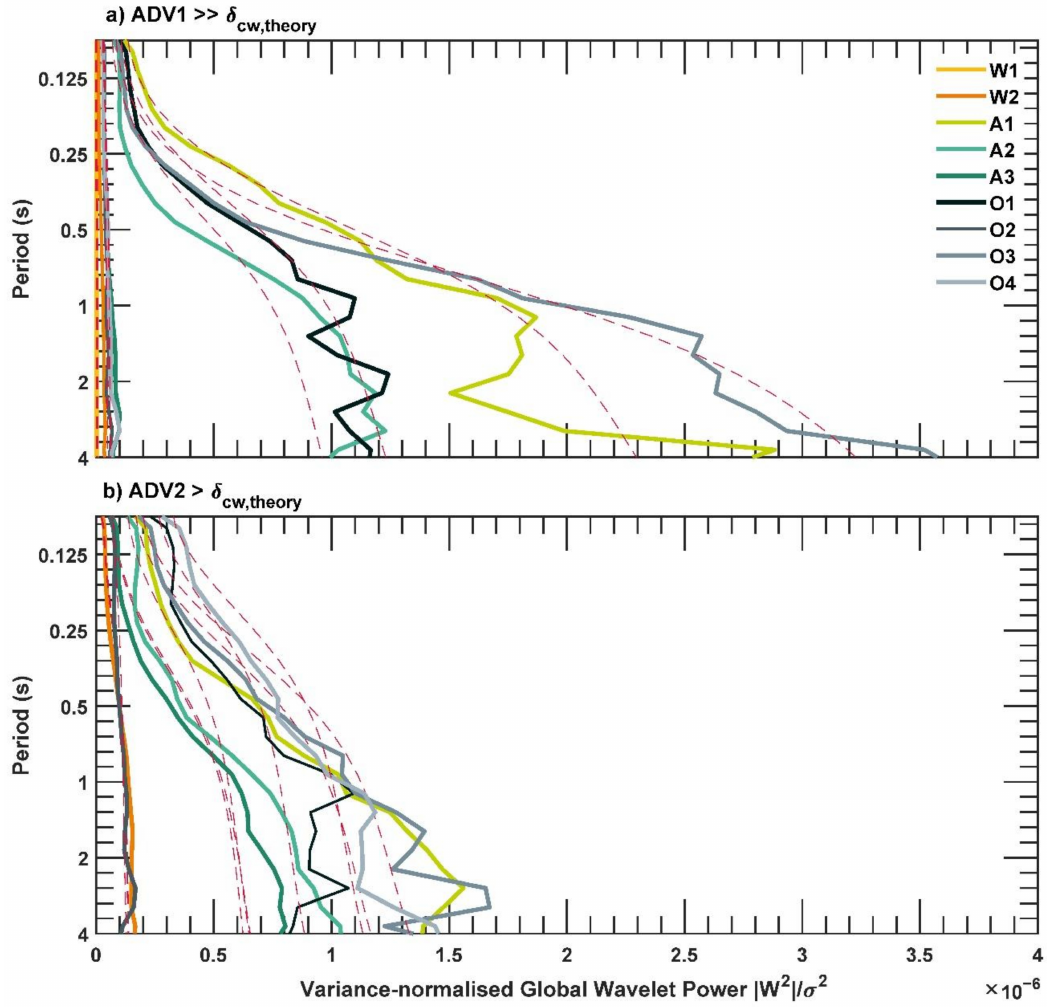
Figure 8. Variance-normalised, global wavelet power of the instantaneous, turbulent momentum flux (Reynolds stress u (cid:48) w (cid:48) in the stream-wise vertical plane), measured at two elevations: ( a ) ADV1 (higher) and ( b ) ADV2 outside the theoretical thickness of the oscillatory boundary layer ( δ cw,theory ) for all test runs. The global power pertains to the time average of all local wavelet spectra (i.e., all the vertical slices through the wavelet plot); and the red lines in these subplots denote the 95% confidence level for the global wavelet spectra, tested in a time-averaged sense using autocorrelation of background